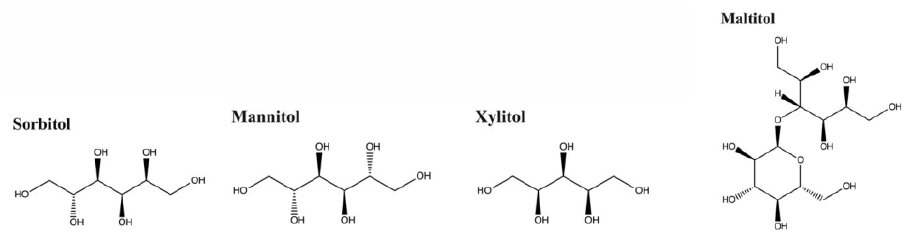
Figure 1. Chemical structures of polyols.